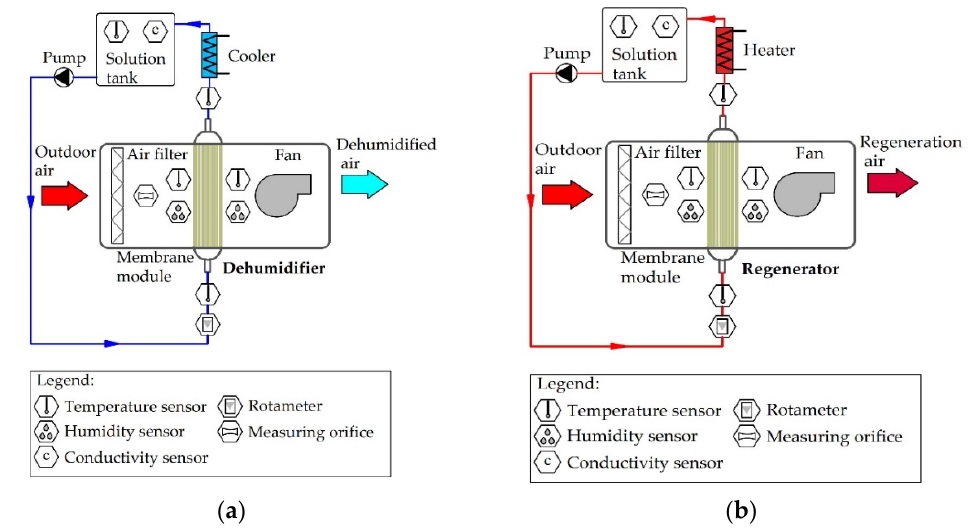
Figure 3. Schematic diagram of the test set–up: ( a ) Operation mode air dehumidification; ( b ) Operation mode solution regeneration.